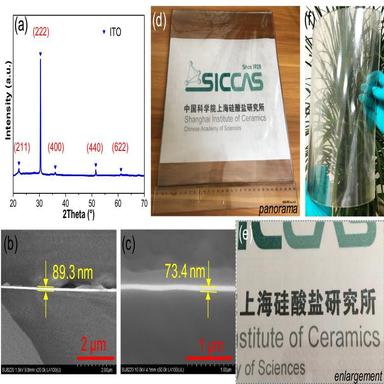
(a) XRD pattern of fabricated ITO film. (b–c) Scanning electron morphologies of the (b) 10-Ω/square ITO film and (c) 15-Ω/square ITO film. Photos of the fabricated (d) WMA material and (e) its metasurface patterns. (f) Bent WMA with great flexibility.